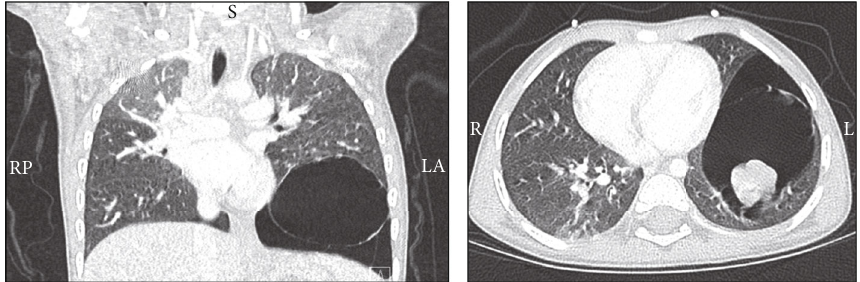
Figure 2: Multiseptated large cystic lesion within the left lower lobe with multiple solid